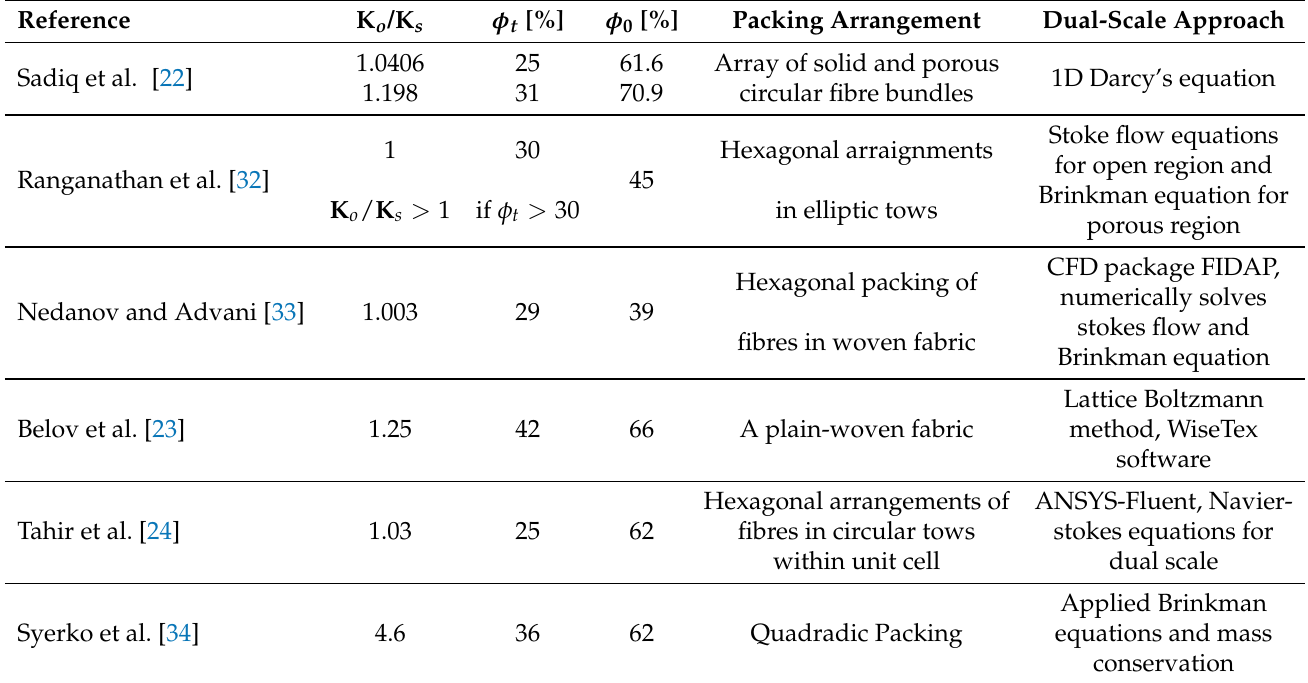
Table 1. Numerical modelling considering dual-scale porous